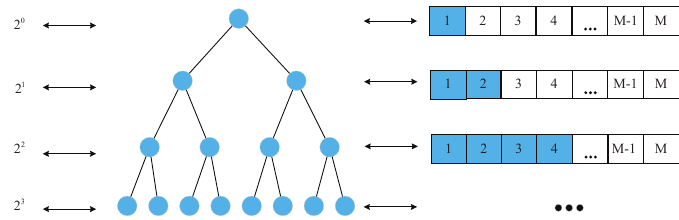
Figure 7. The mapping relationship between binary tree model and the number of reservable